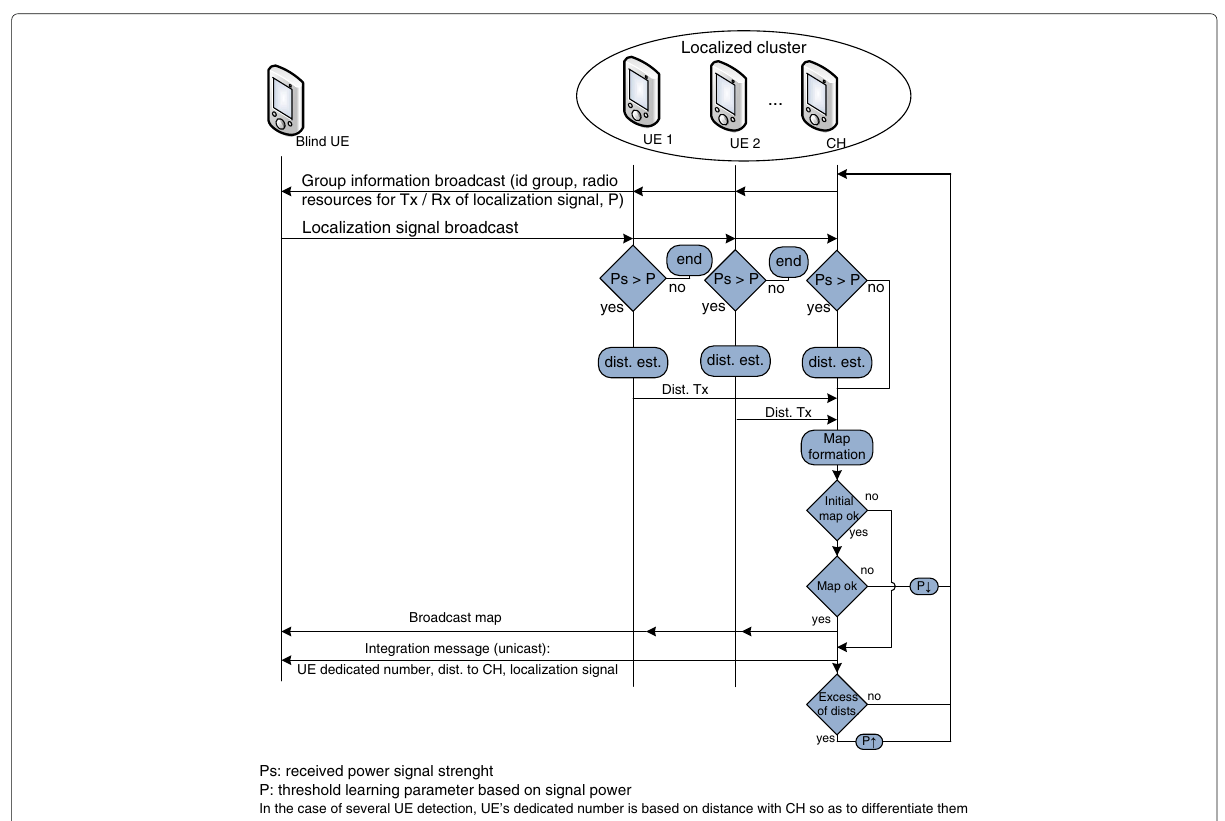
Fig. 10 General map steps. This figure represents the general diagram steps in order to create a map of